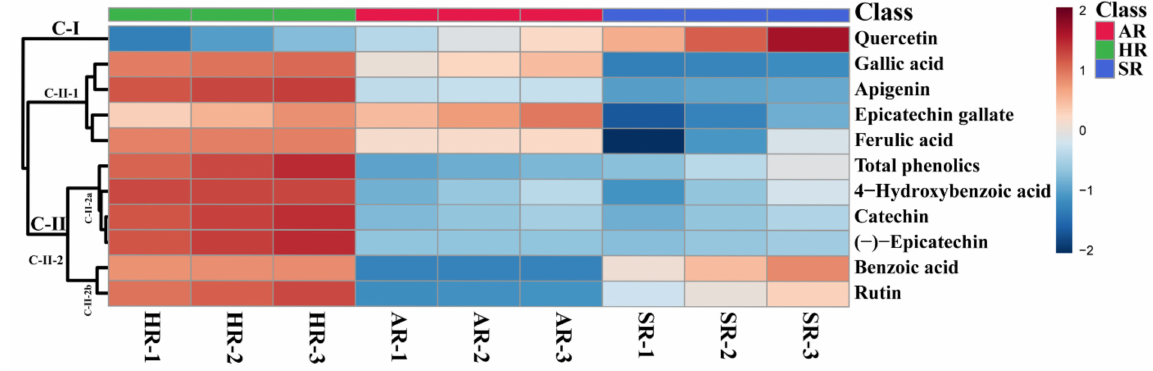
Figure 7. Heat map representing the change in the concentration of relative metabolites in root cultures of F. tataricum